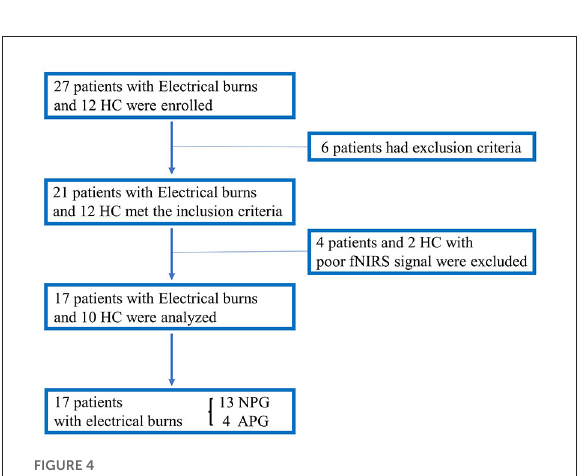
FIGURE4 Flowchart showing enrollment of the study population. APG, electrical burn patients with abnormal HUT results; HC, healthy controls; HUT, head-up tilt table test; NIRS, near-infrared spectroscopy; NPG, electrical burn patients with normal HUT